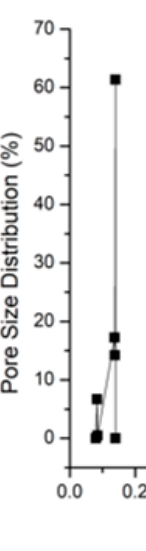
Figure 4. ( a ) Pore size and distribution of the membrane samples. SEM cross-sectional image of ( b ) flat and ( c ) corrugated membranes. Notice the different magnifications of the SEM images in ( b , c ).